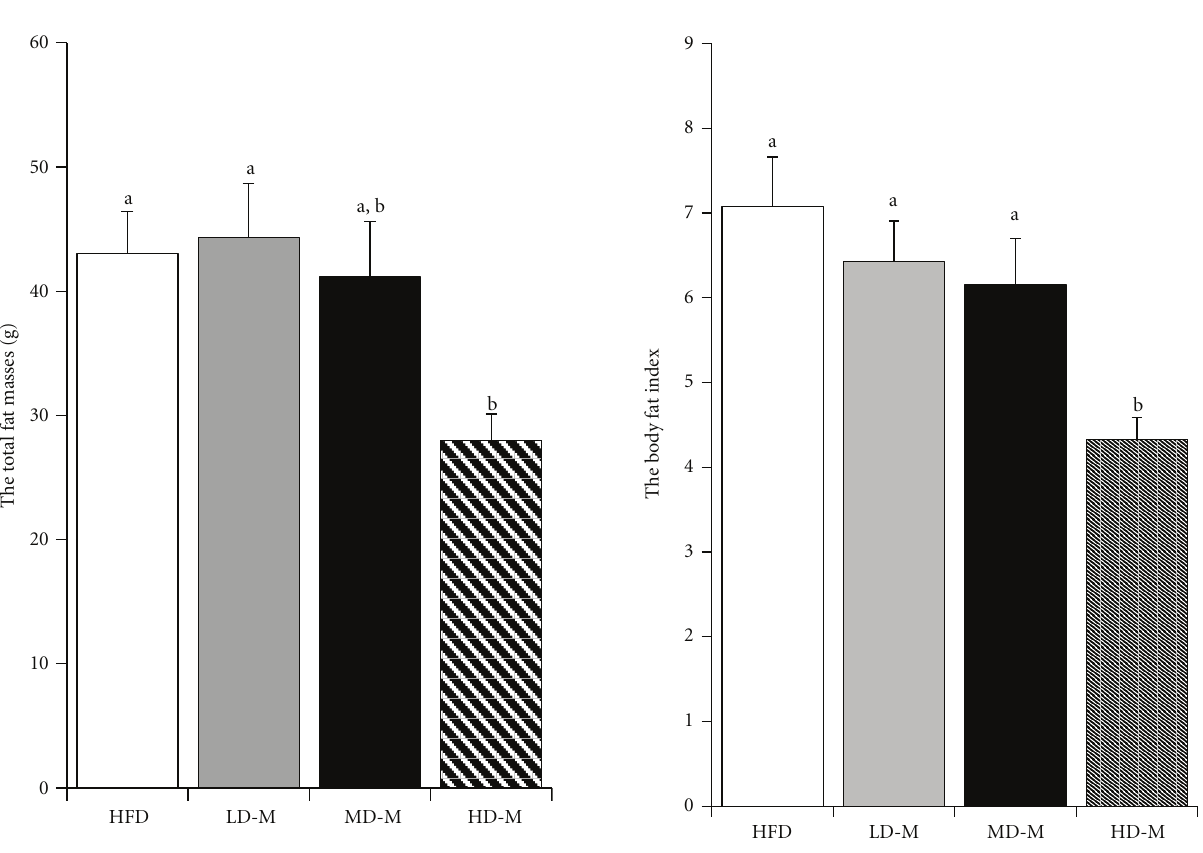
Figure 2: Body fat index was measured after 6-week dietary treatments in rats. Bars represent means ± standard errors, n = 10. ab Means not sharing a common letter are significantly di ff erent among groups at P < 0 .